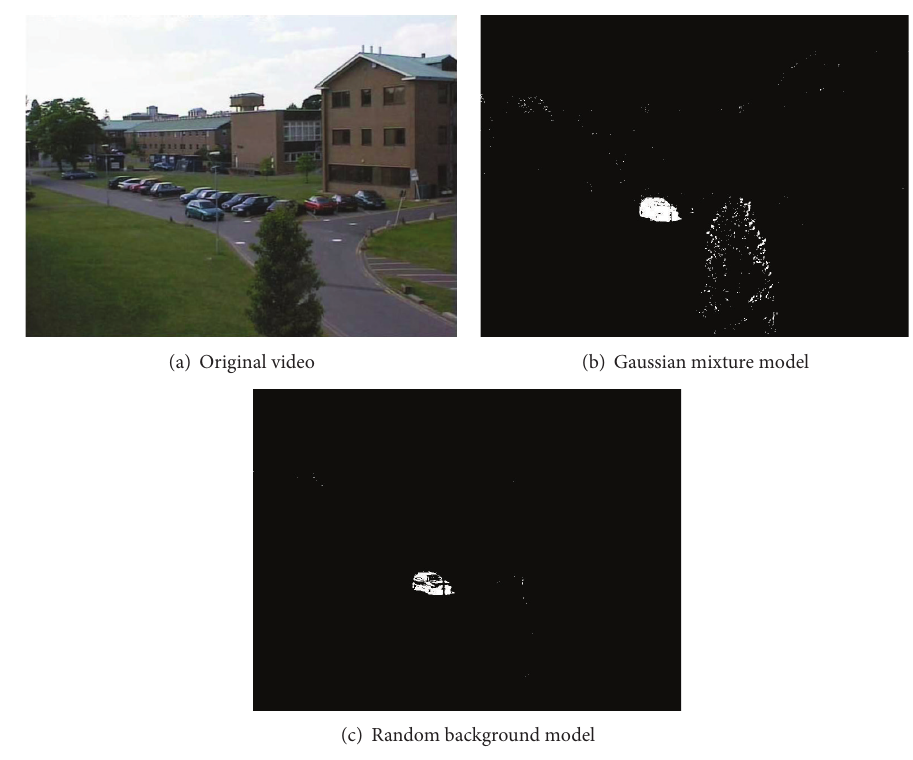
Figure 2: The target detection results of video data 1.